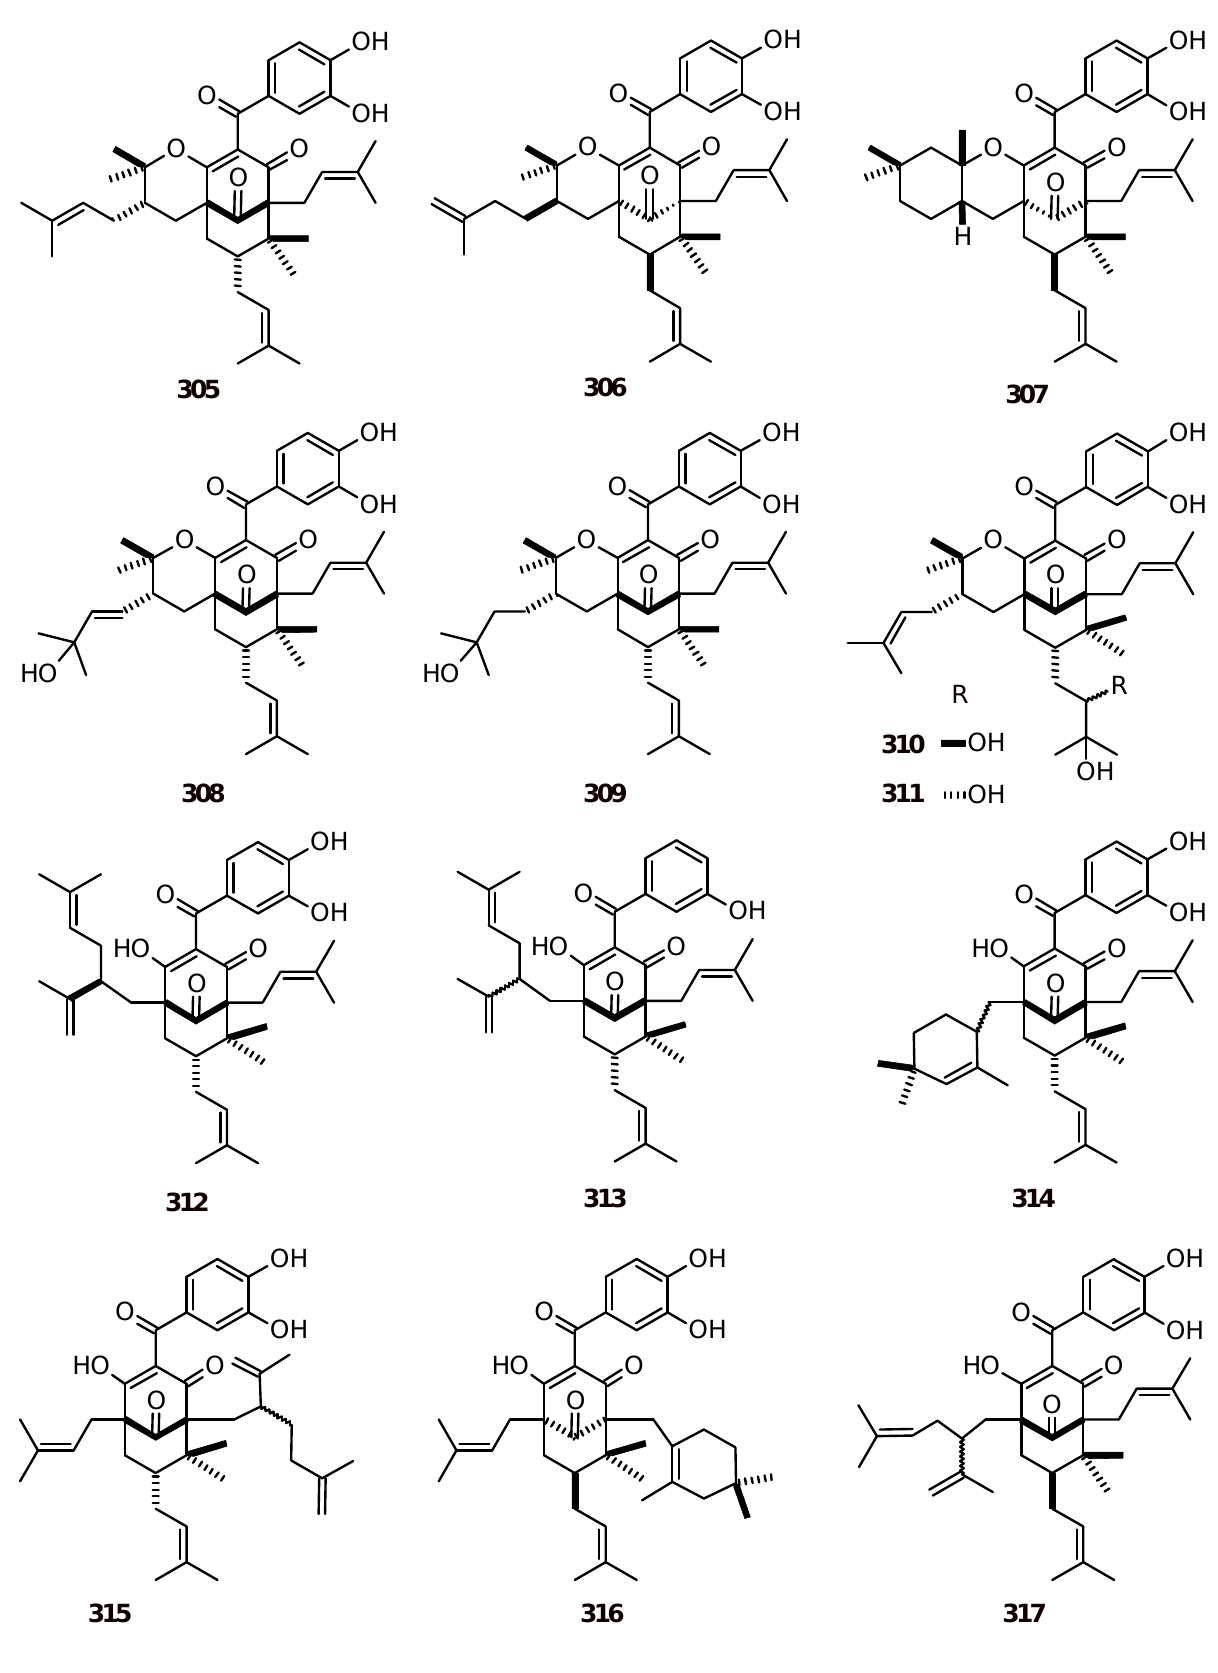
Figure 39. Structures of benzophenones 305 - 330